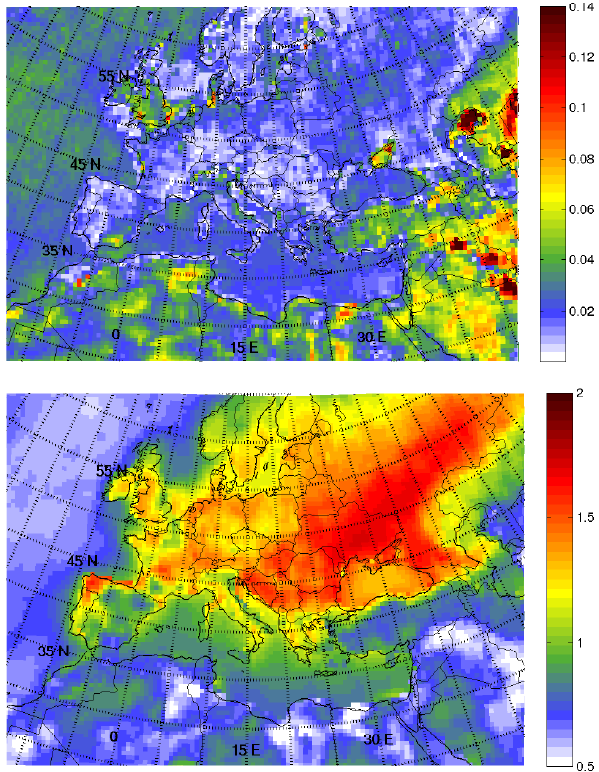
Fig. 18. Standard deviation of total AOD at 550nm (top) and Angstrom exponent (AQUA/MODIS, bottom) over the Mediter- ranean region for the 2003–2009 period.